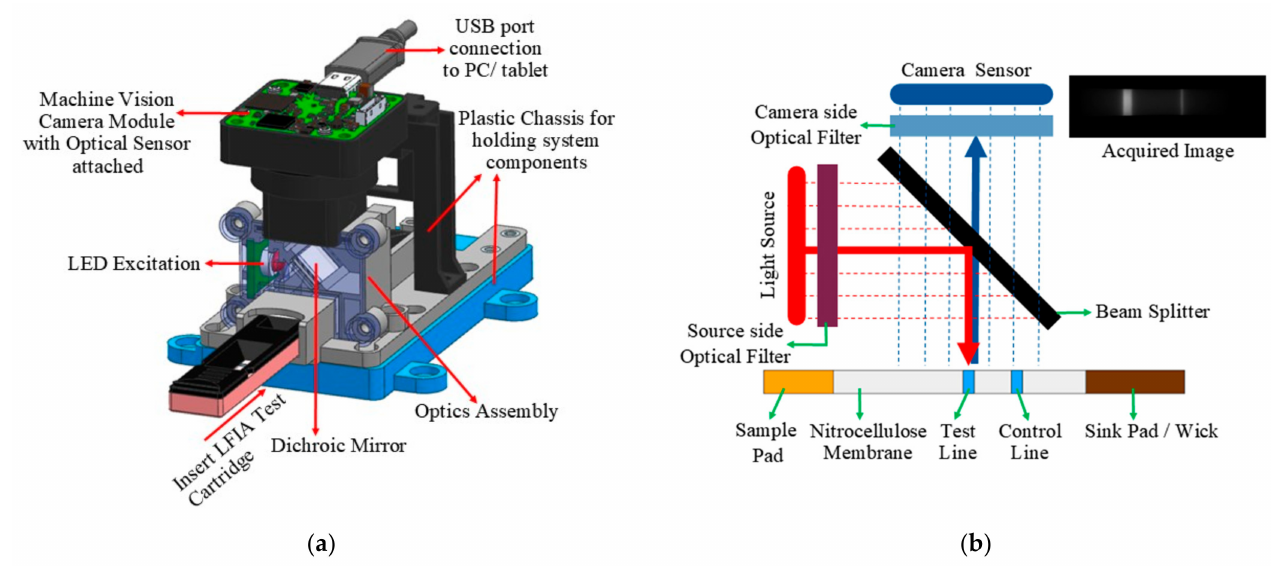
Figure 2. ( a ) Hardware setup of the fluorescence reader indicating different components of the system and the confocal arrangement. ( b ) Principle of operation of the designed